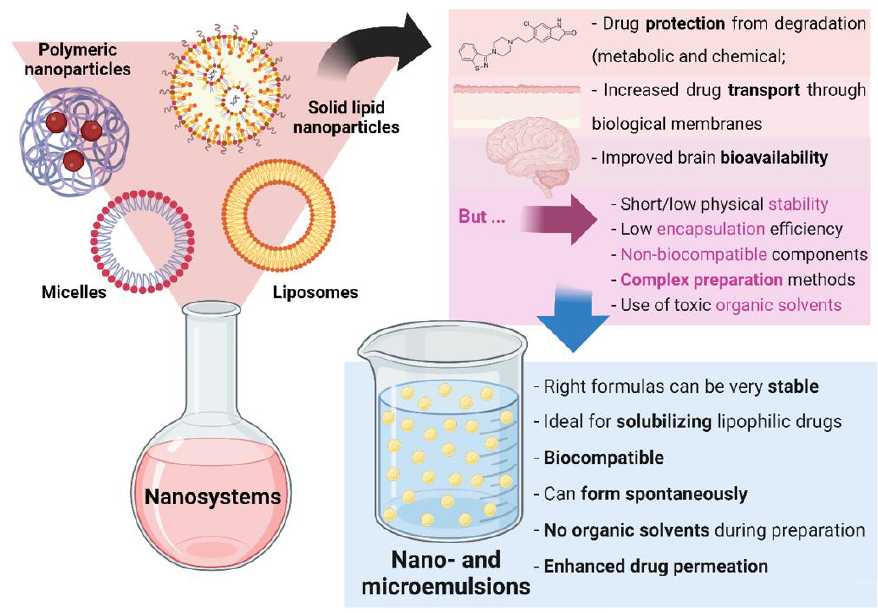
Figure 2. General nanosystem types and their characteristics, as well as the advantages of nano and microemulsions.